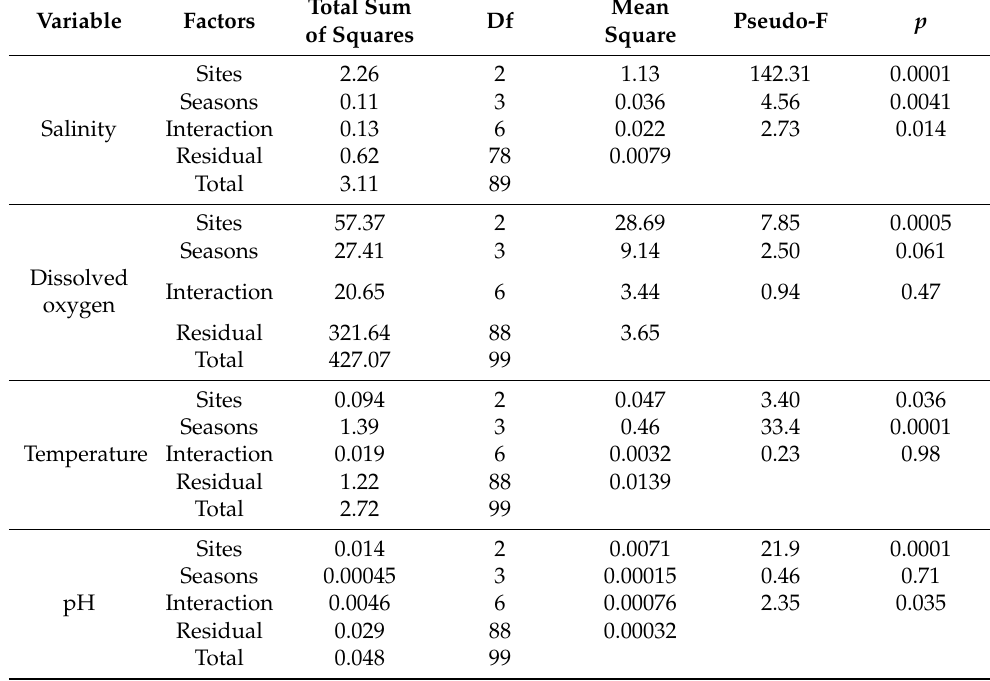
Table 1. Results of two-way PERMANOVA (Bray-Curtis-(dis)similarity-based) testing differences between sites and seasons and their interactions for each of the considered environmental